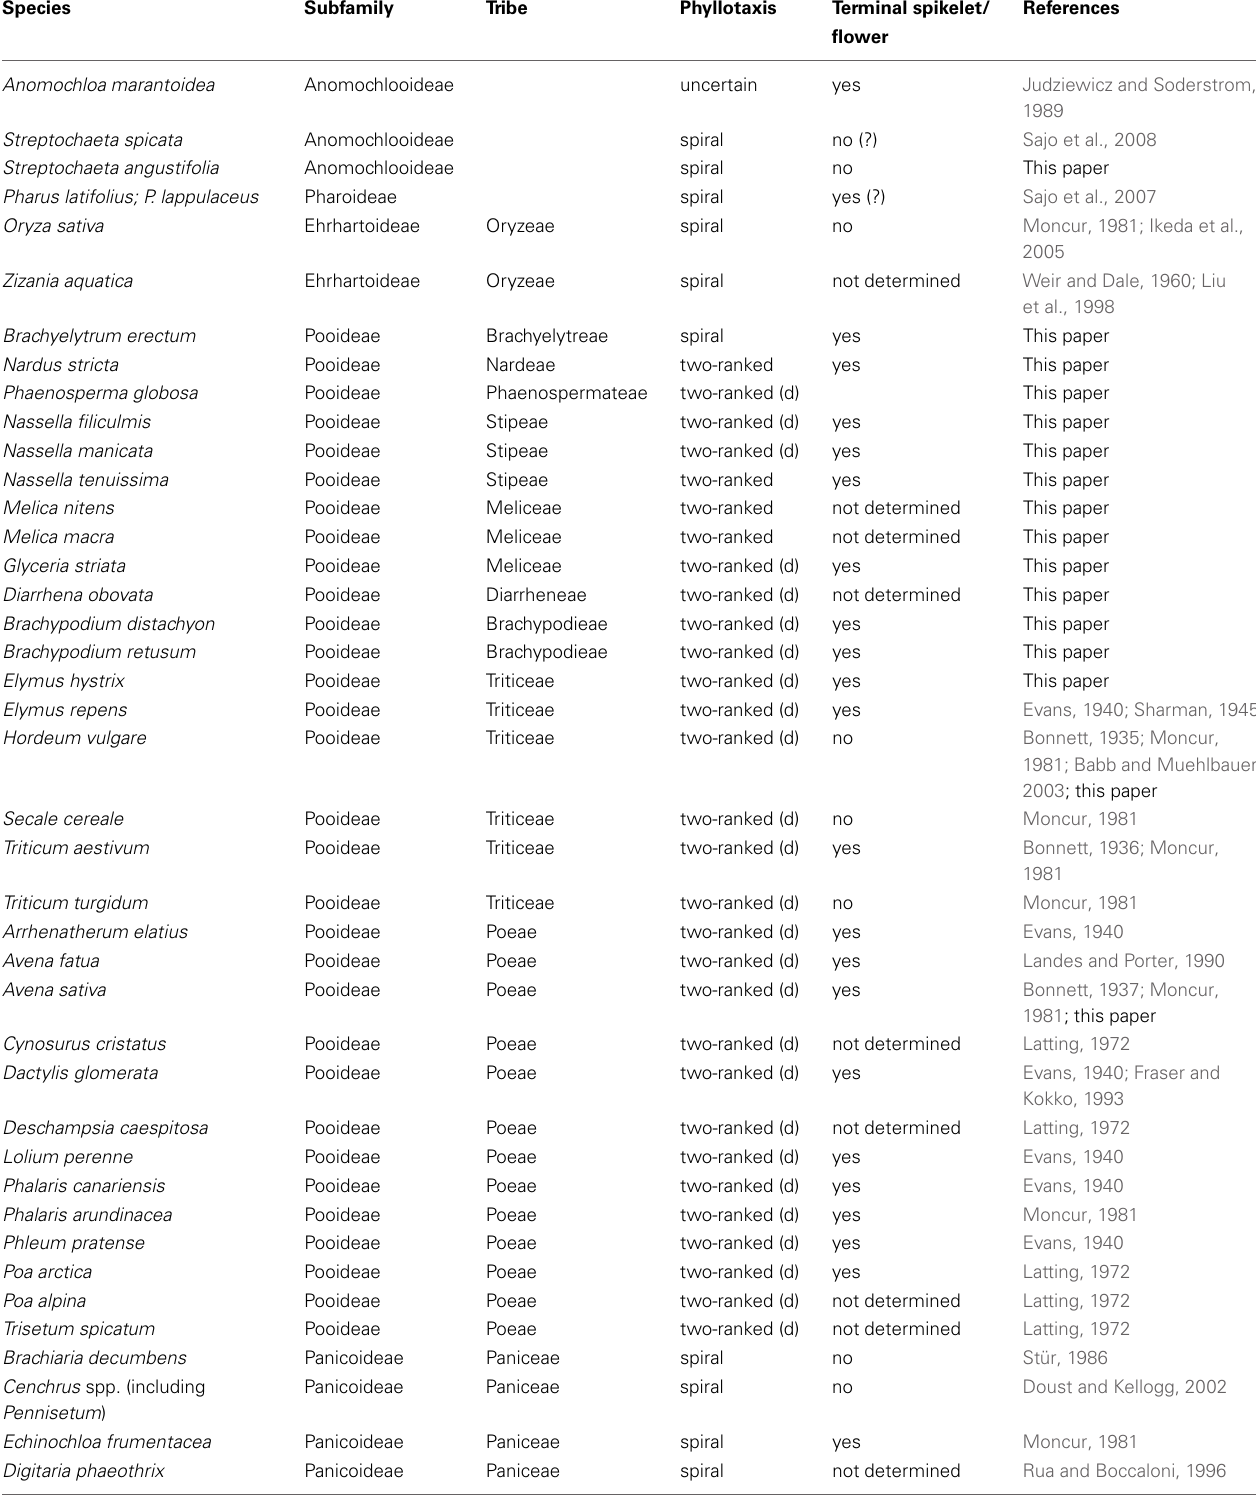
Table 1 | Phyllotaxis of primary inflorescence branches and presence of a terminal flower in the grasses; taxa in which the two-ranked inflorescence is distichous are indicated as “two-ranked